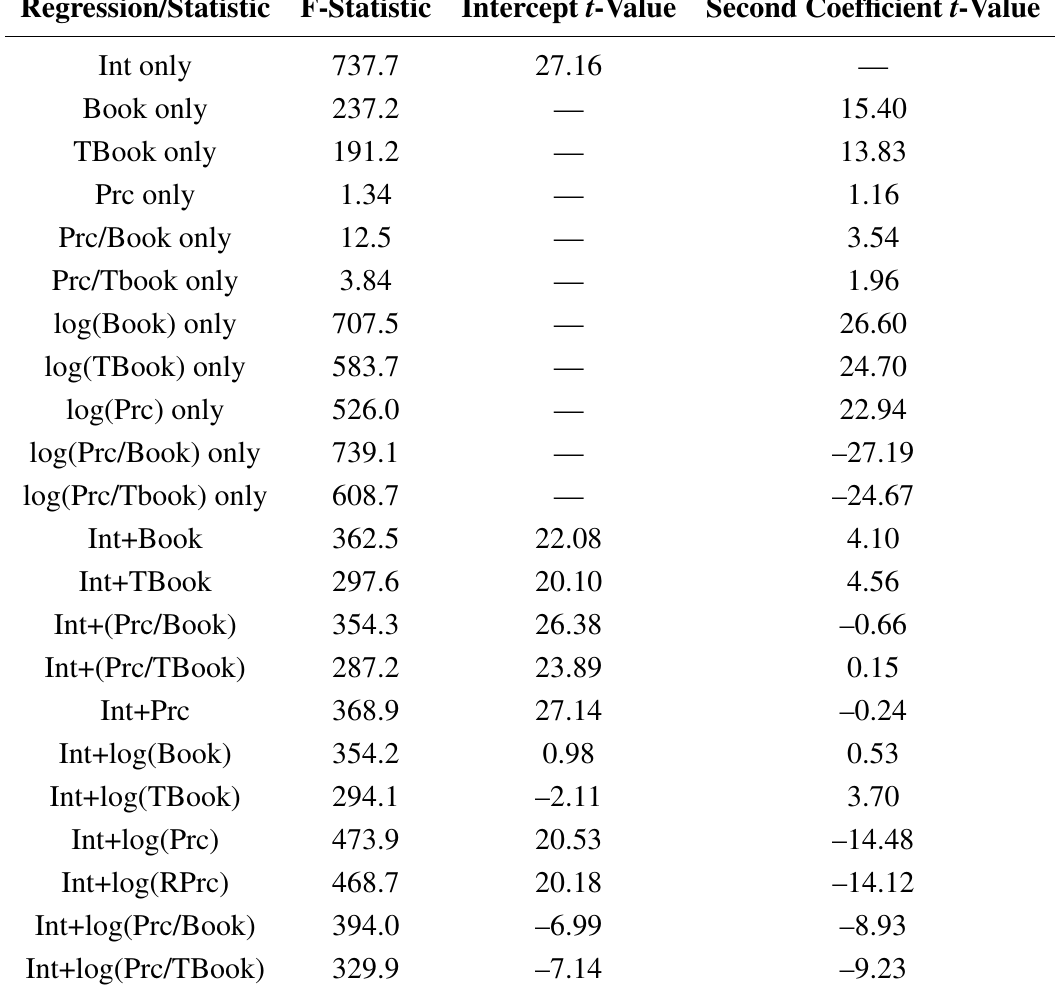
Table 1. Results for regressions (56) and (57) with the intercept-only 1-factor model as the benchmark. Int = intercept; (T)Book = (tangible) book; Prc = adjusted previous close; RPrc = raw (unadjusted) previous close. Next to Int+log(Prc) we also give Int+log(RPrc) results. We do this because adjusting the previous close introduces a bias of